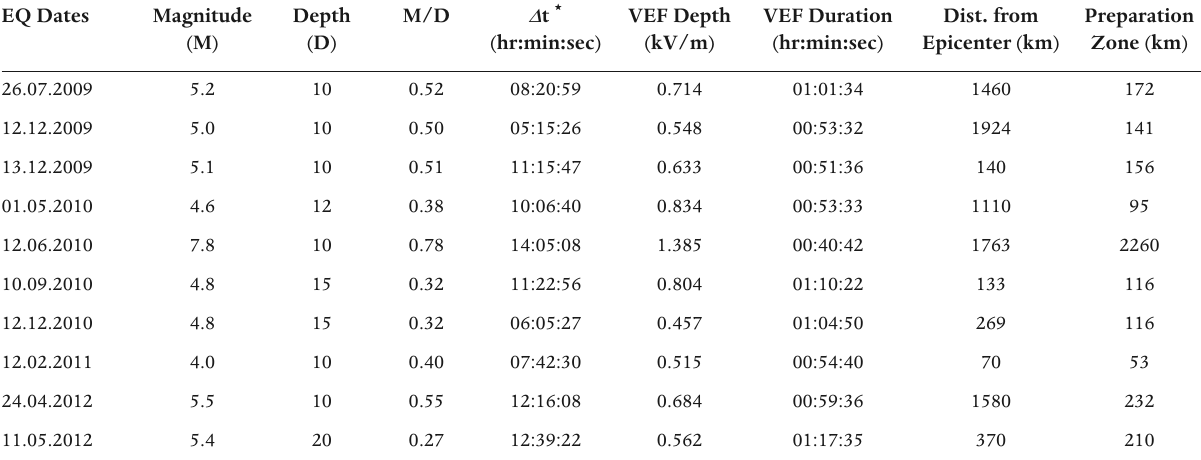
Table 1. Details of the 10 earthquake days where the precursors were observed. D t * , time difference between occurrence of bay-like varia- tion in the VEF and the earthquake.